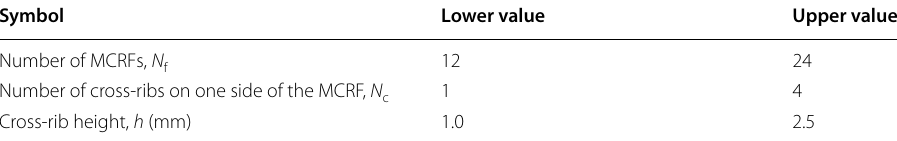
Table 2 Variation ranges of independent variables Symbol Lower value Upper value Number of MCRFs, N f 12 24 Number of cross-ribs on one side of the MCRF, N c 1 4 Cross-rib height, h